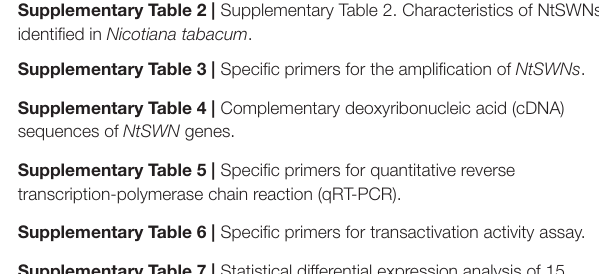
Nicotiana tomentosiformis , and Nicotiana tabacum (K326). Supplementary Table 2 | Supplementary Table 2. Characteristics of NtSWNs identified in Nicotiana tabacum . Supplementary Table 3 | Specific primers for the amplification of NtSWNs .